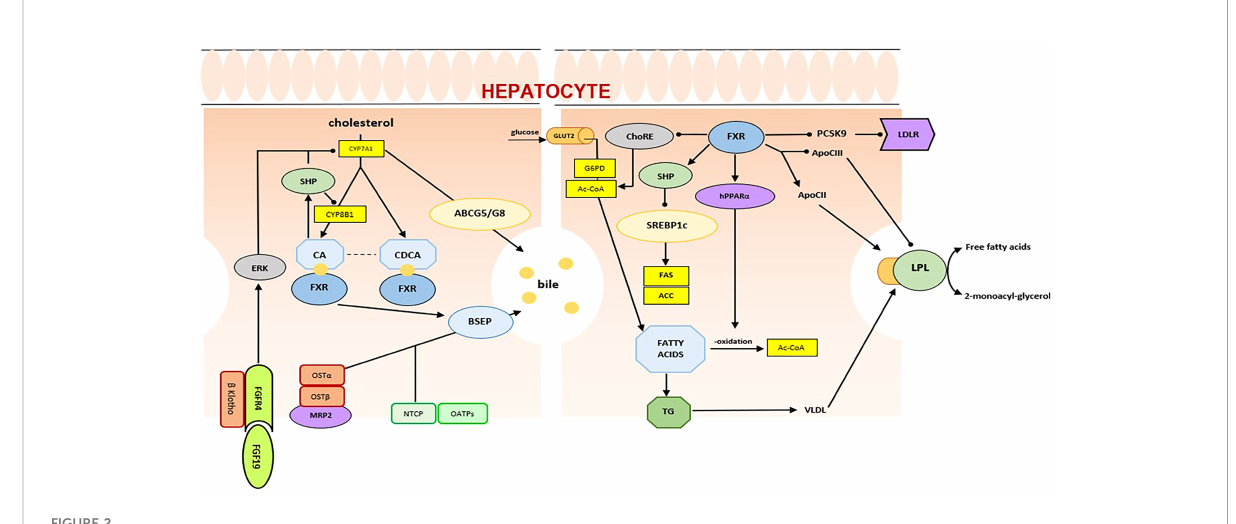
FIGURE 2 FXR in bile acid and lipid